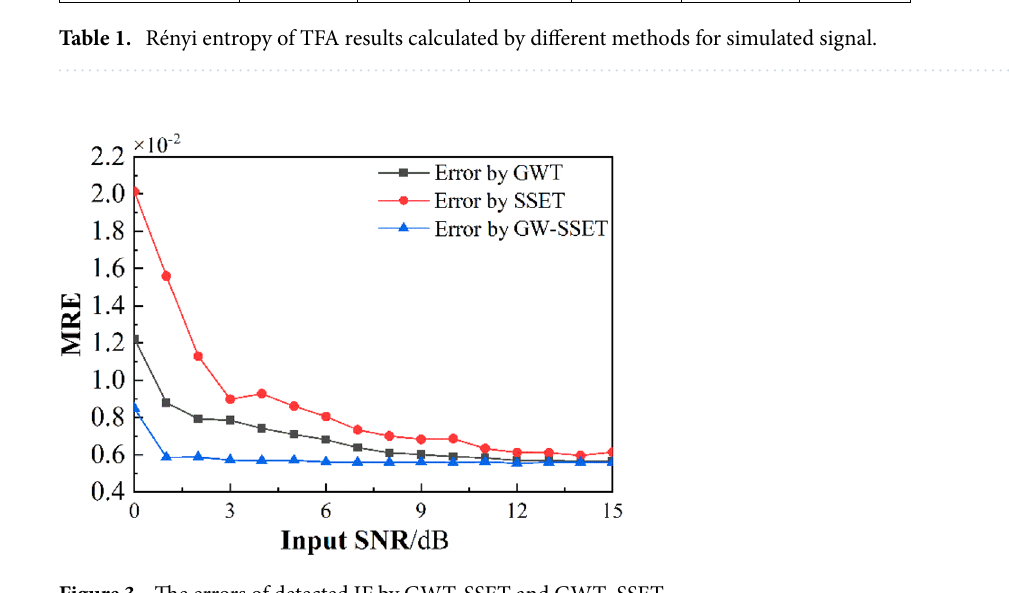
Figure 3. The errors of detected IF by GWT, SSET and